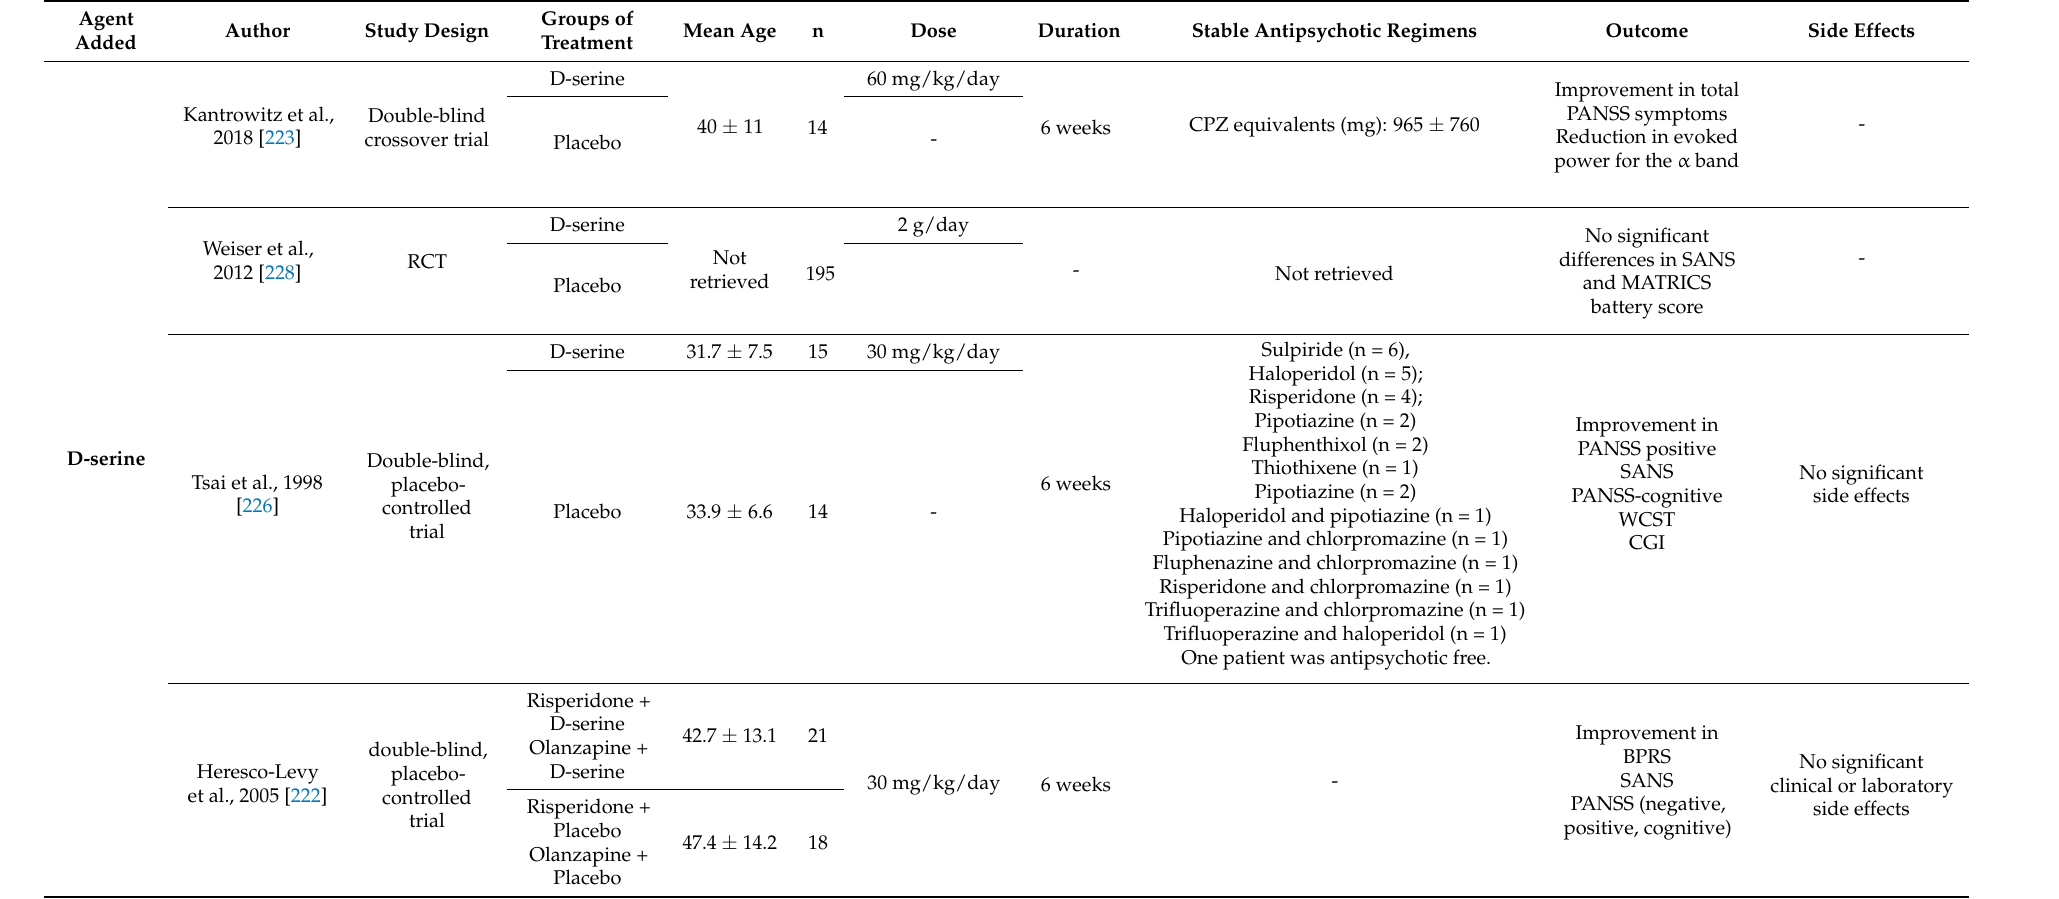
Table 1. Randomized clinical trials investigating the efficacy of D-amino acids in treating